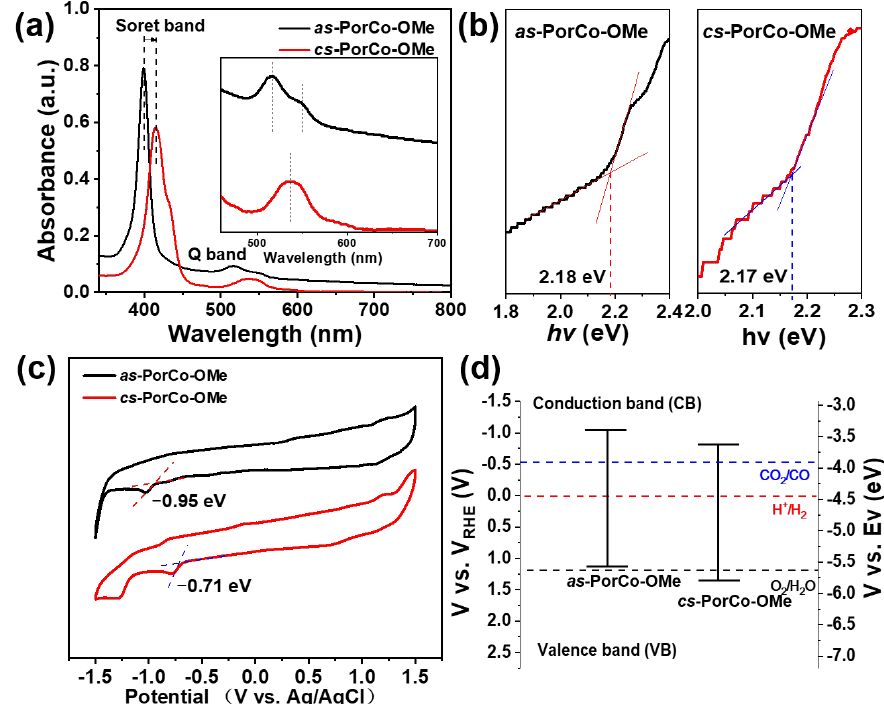
Figure 2. ( a ) FTIR spectra of as -PorCo-OMe and cs -PorCo-OMe; High resolution Co 2p ( b ), N 1s ( c ) and C 1s ( d ) XPS spectra in as -PorCo-OMe.